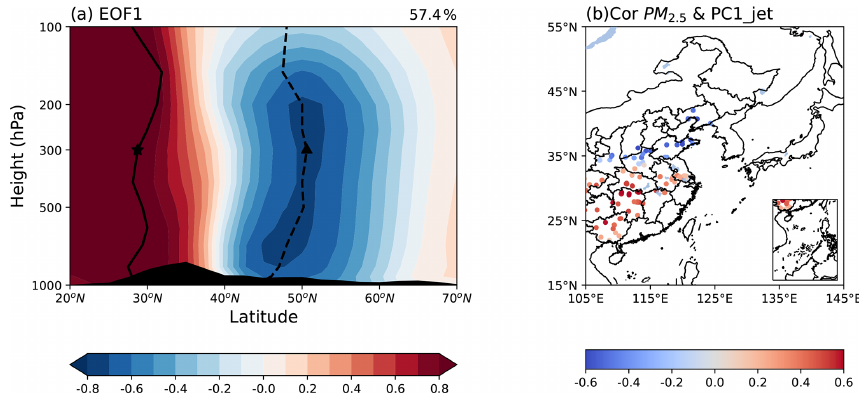
Figure 8. (a) The first EOF mode of zonal wind (EOF1, ms − 1 ) averaged from 60 to 160 ◦ E in NDJF. The star and triangle at 300hPa denote the subtropical jet and polar-front jet cores, respectively. The zonal mean orography is dark-shaded. (b) Correlation coefficients between Type2 PM 2 . 5 concentrations and PC1_jet.